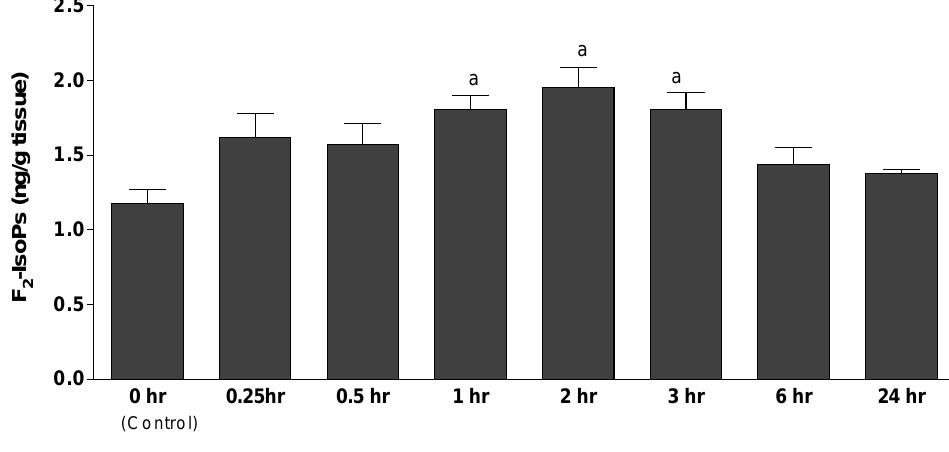
FIGURE 4. Effect of CF (1.5 mg/kg, s.c.) on F 2 -IsoPs levels in EDL muscles. Values are mean ± SEM (n = 4–6). a Significant difference between control and CF-treated rats ( p < 0.05).